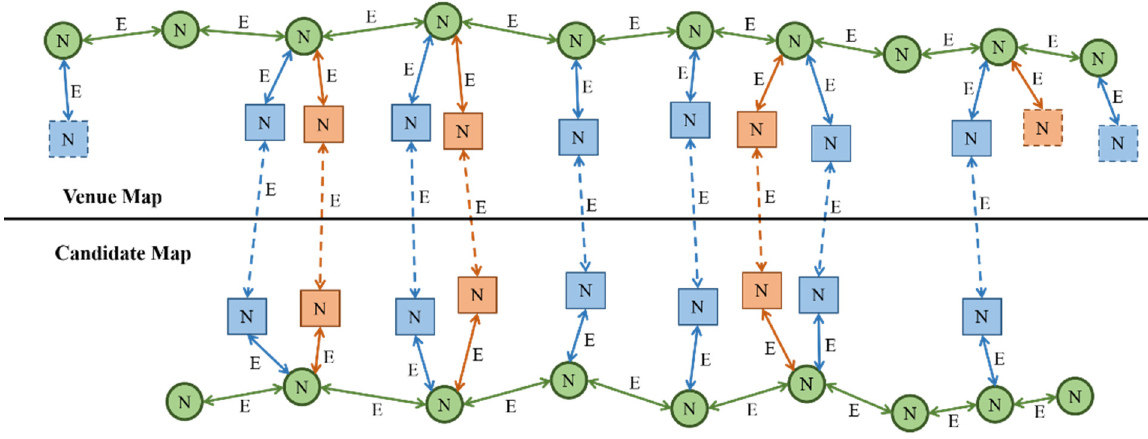
Figure 4. The schematic diagram of the optimization graph.